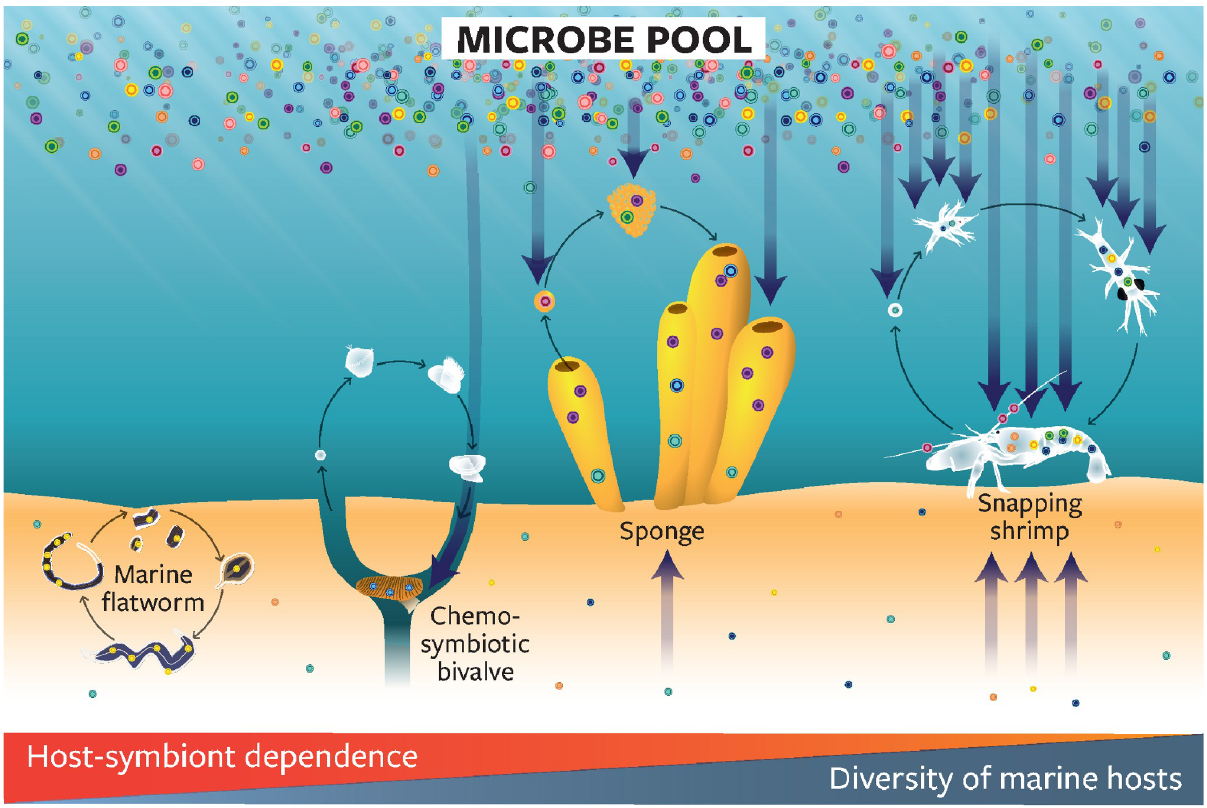
Fig 3. The role of microbes in the host’s response to environmental changes is contingent upon their predominant mode of transmission. Microbes that are present in the marine environment represent a vast pool of standing genetic variation. The majority of marine species with horizontal (e.g., lucinid clams and snapping shrimps) or mixed mode of symbiont acquisition (e.g., sponges) interact with a large number of microbes that they acquire during their lifetime. The ability to draw on this large evolutionary potential by switching microbes or gaining new genes potentially allows hosts to respond rapidly to environmental changes. At the other end of the spectrum, the few marine hosts with strictly vertically transmitted symbionts (e.g., flatworms) have less opportunity to exchange genes to rapidly adjust the symbiosis to changing